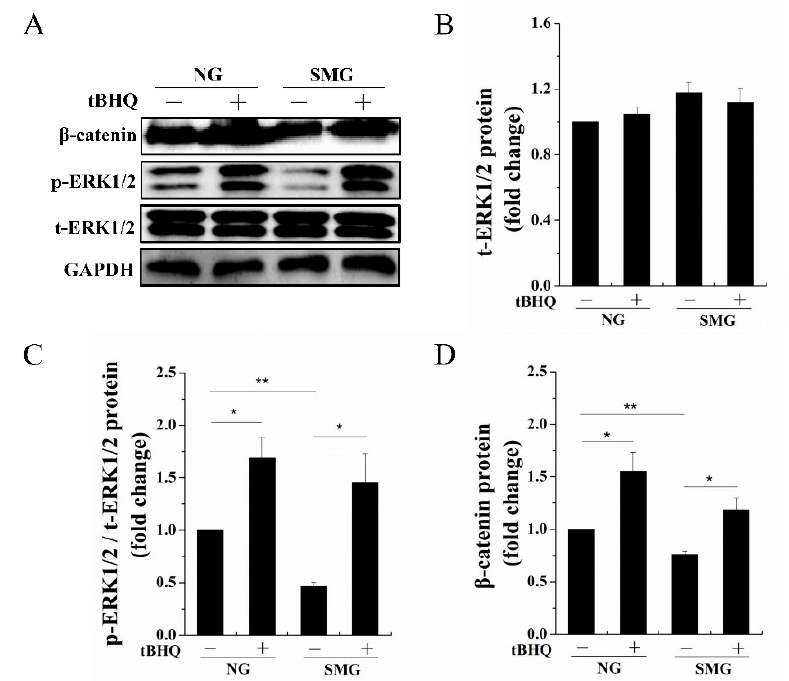
Figure 5. The role of phosphorylation of ERK1/2 in the differentiation of BMSCs into dermal fibroblasts under SMG conditions. ( A ) Western blot detection of the t-ERK1/2, the p-ERK1/2, and the β -catenin protein level in NG, NG + tBHQ, SMG, SMG + tBHQ. ( B – D ) Quantification data of Western blot detection of the t-ERK1/2, the p-ERK1/2, and the β -catenin protein level in NG, NG + tBHQ, SMG, SMG + tBHQ. SMG: simulated microgravity; NG: normal gravity; BMSCs: bone marrow-derived mesenchymal stem cells; tBHQ: tert-Butylhydroquinone; t-ERK1/2: total extracellular regulated protein kinases 1/2; p-ERK1/2: phosphorylation of extracellular regulated protein kinases 1/2; GAPDH: glyceraldehyde-3-phosphate dehydrogenase. Data are presented as mean with SD; n = 3, * p < 0.05; ** p <